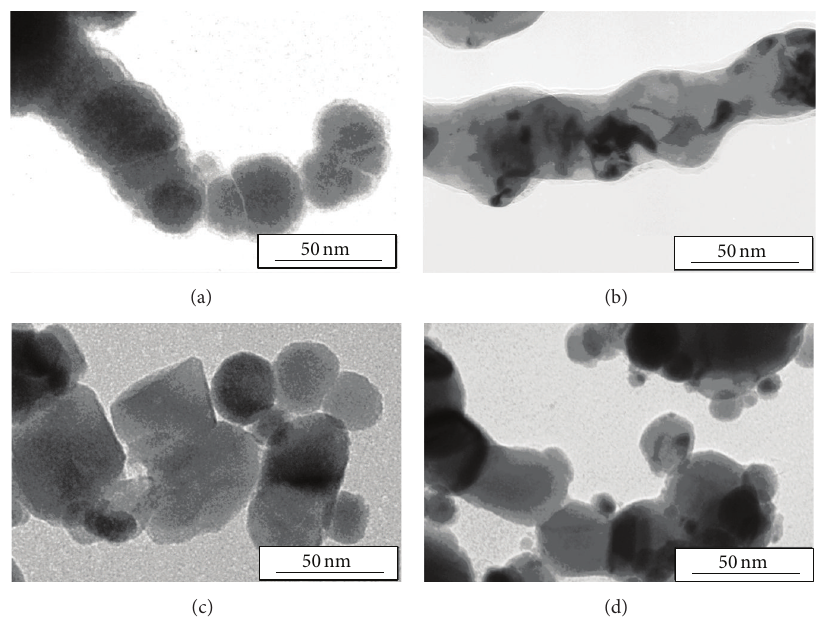
Figure 1: Transmission electron microscopy (TEM) images of nano-Fe 0 (a), VA-nano-Fe 0 (c), nano-Fe 3 O 4 (b), and VA-nano-Fe 3 O 4 (d).